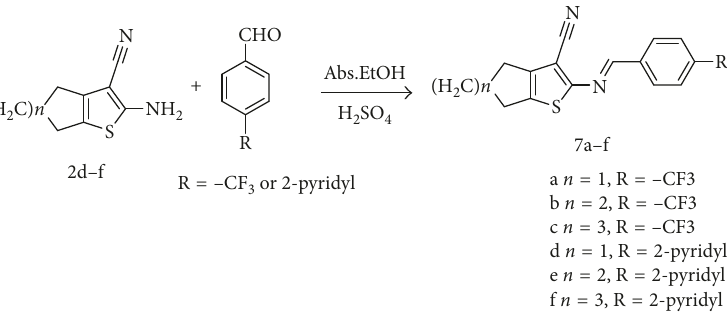
Scheme 6: Synthesis of thiophene-3-carbonitrile derivatives ( 7a–f Table 1: Experimental detail of the crystalline structures of 4c and 7e .